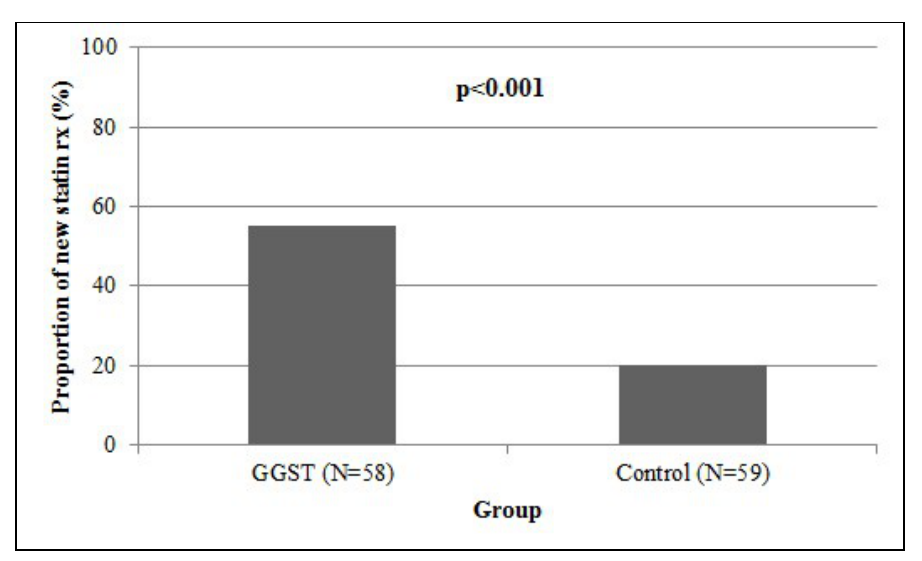
Figure 2. Association of GGST with new statin prescriptions. Individuals receiving GGST had a higher proportion (55%) at four months following genotyping compared to control subjects (20%) followed for one year. GGST = genotype guided statin therapy.